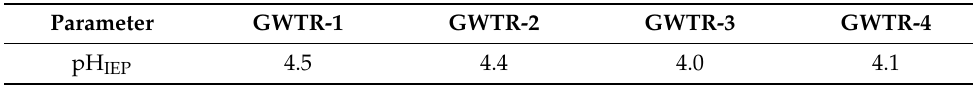
Table 4. Determination of the pH of the zero point of charge for